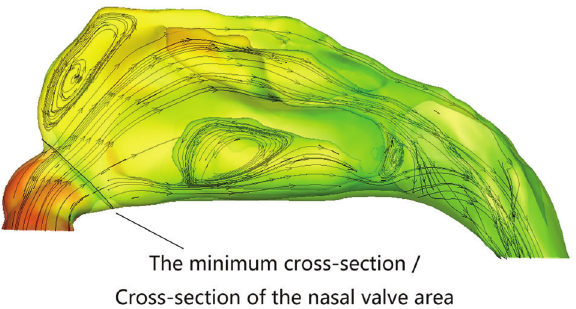
Figure 2. Transversal section of the nasal cavity. Circled area represents the minimum/total cross-section of the nasal valve area. The arrows show the air fl ow